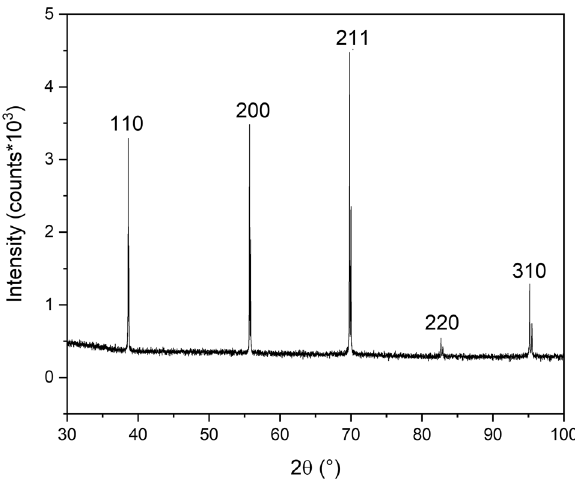
Figure 1. XRD analysis of the TNZT alloy used as the substrate for the anodic growth of TNTs and TNWs. All the reflections observed are from the body-centered cubic (β) phase of